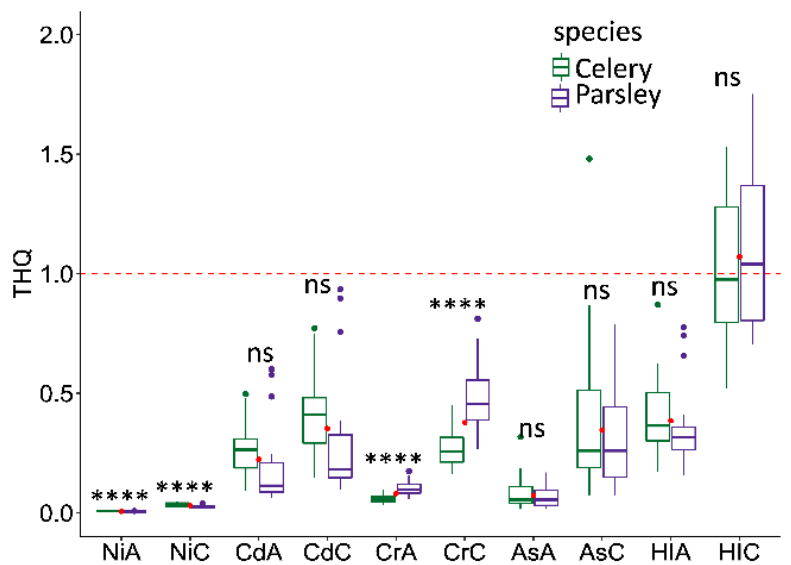
Figure 2. Target hazard quotients—THQ of Ni, Cd, Cr, As, and hazard index (HI) of celery and parsley. Values are calculated for both adults (A) and children (C) ( n = 21). The line within the boxplots represent the median, the ends of the box show the upper (Q3) and lower (Q1) quartiles, the extreme lines show Q3 + 1.5 × IQR to Q1 − 1.5 × IQR, the dots beyond the extreme lines represent outliers, while red dots are the mean values of both groups. Red dashed line defines the limit of 1, where the values greater than 1 indicate potential non-cancerogenic risk. Significance codes: ns—non-significant; **** p ≤ 0.0001.